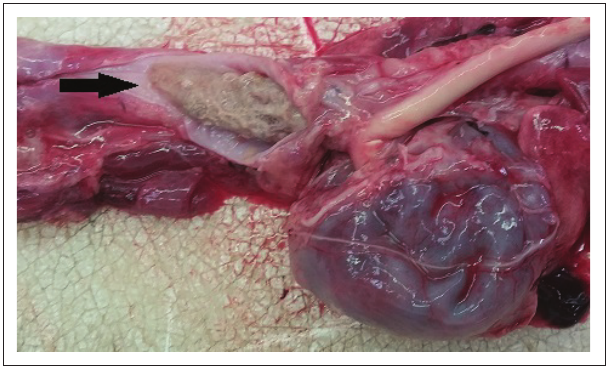
FIGURE 3: Post mortem photograph. Note the cartilaginous foreign body, indicated by the arrow, clogged with food lodged in the oesophagus cranial to the heart base.